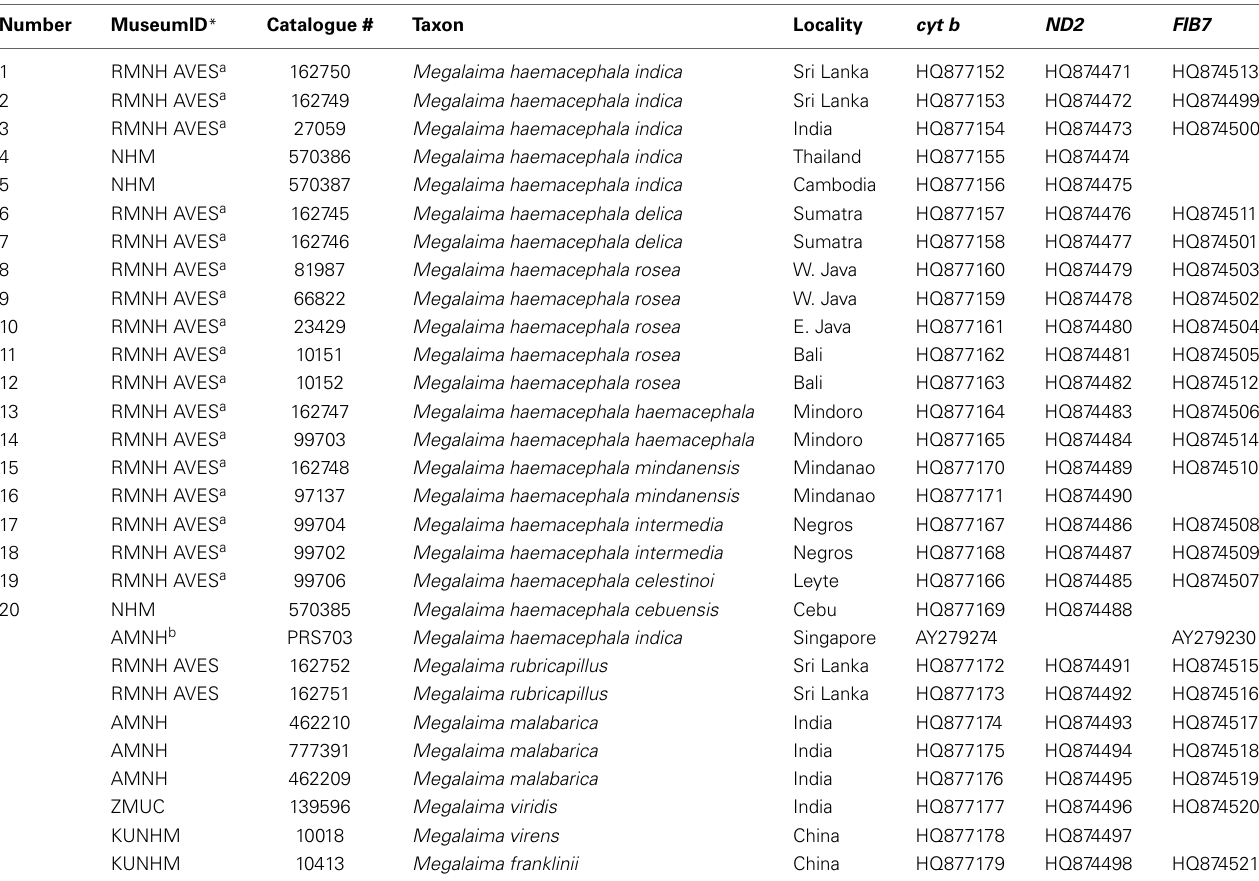
Table 1 | Specimens used in this